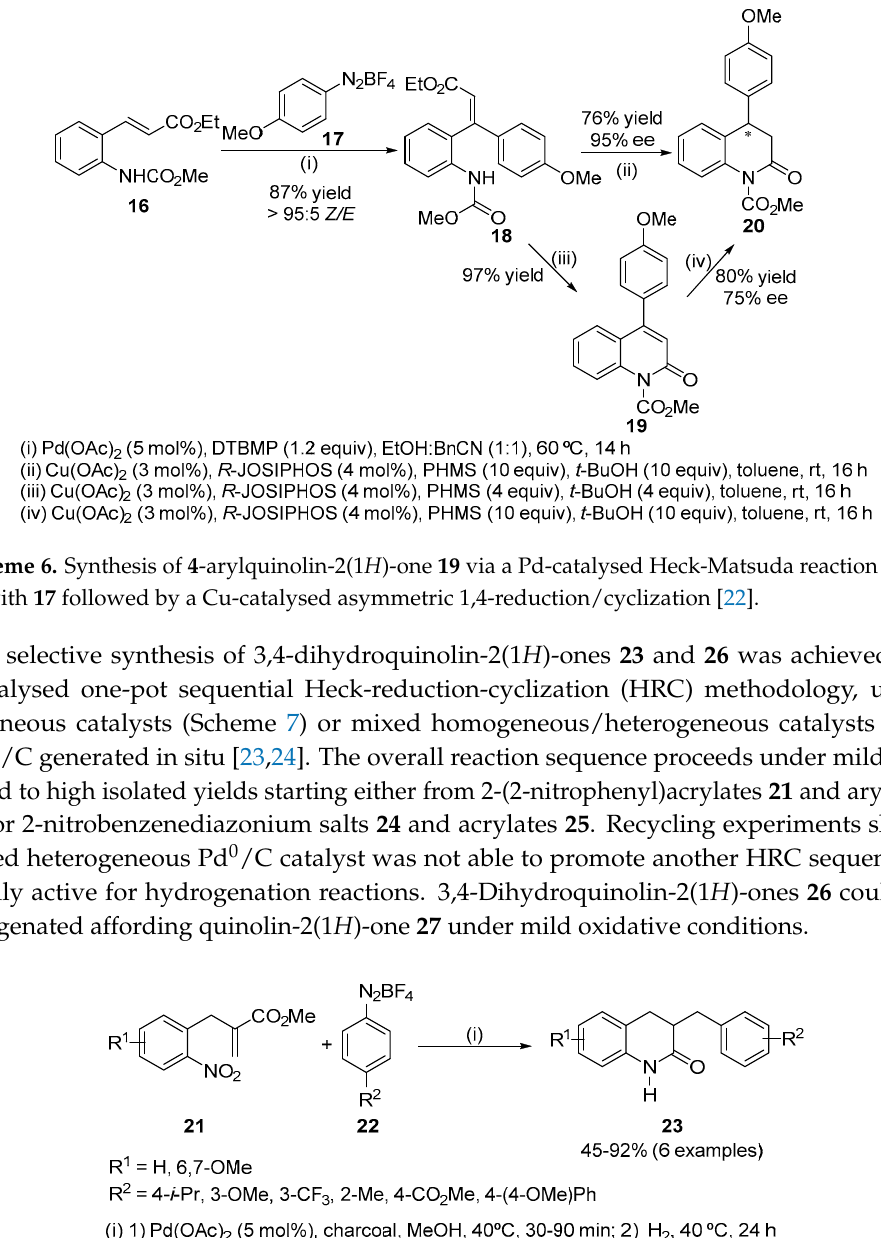
Scheme 5. Synthesis of 3-substituted quinolin-2(1 H )-ones 15 via Heck coupling-cyclization of 2-iodoaniline 1 with α , β -unsaturated carbonyl compounds 14 [21].